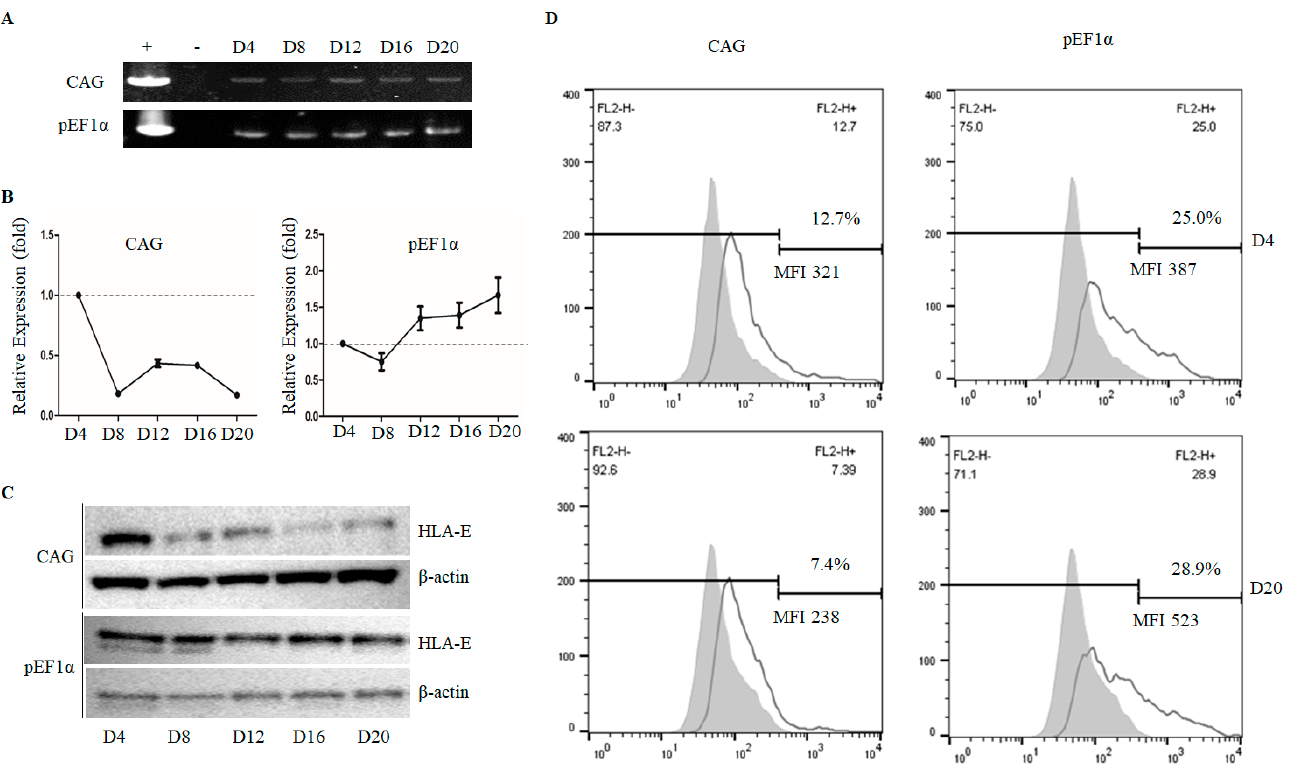
Figure 5. The pEF1 α promoter mediates stable HLA-E expression during long-term culture. ( A ) CAG- and the pEF1 α -HLA-E expression cassettes were transfected into PEFs and then selected as described in detail in the Materials and Methods. Genotype analysis revealed that the transfectants carried the cassettes on day 4 (D4), day 8 (D8), day 12 (D12), day 16 (D16), and day 20 (D20) after 10 days of primary selection. ( B ) Comparative analysis of HLA-E mRNA expression at D20 compared with that at D4. Values are means ± SEM calculated from three replicates. ( C ) Western blot analysis of HLA-E expression on different days of selection. ( D ) Flow cytometry analysis for HLA-E at D20 compared with that at D4. “+”, positive control; “ − ”, negative control; CAG, cytomegalovirus enhancer/chicken β -actin promoter; pEF1 α , porcine elongation factor 1 α ; HLA, human leukocyte antigen E; MFI, mean fluorescence intensity.